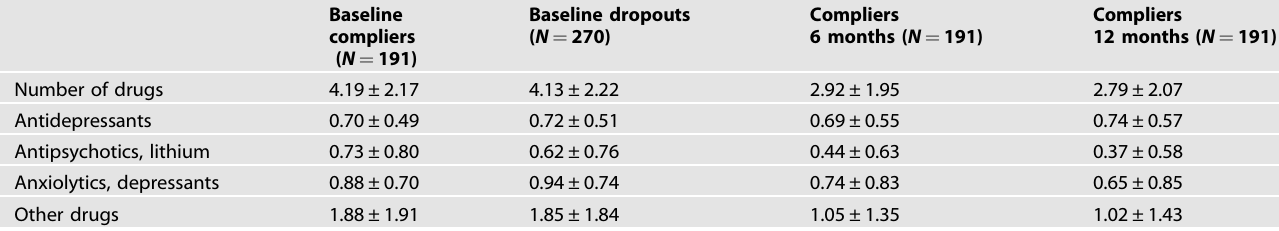
Data are expressed as mean±